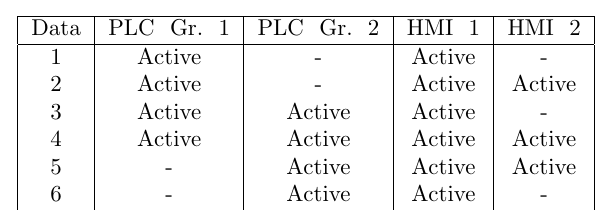
Table 1. Different configurations of the network